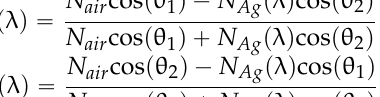
Figure 6. The spectral shift amplification (SSA) effect with the second minimum with band width Γ = 100 nm and the two central wavelengths λ c are 0.22 µm and 0.25 µm.The SSA factor is 1.8.